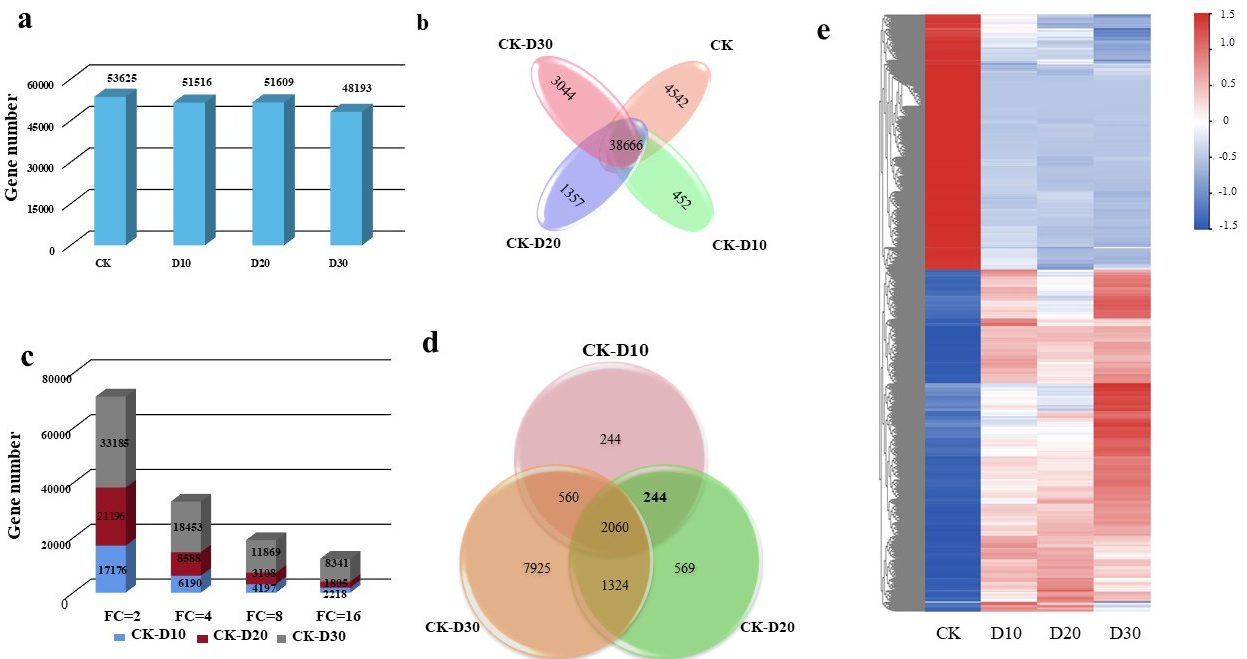
Figure 2. The DEGs’ overview. ( a ) A histogram of the numbers of valid genes in the four samples. ( b ) Venn diagram showing the identification of valid genes in the four samples. ( c ) The number of DEGs with different fold changes. ( d ) Statistical analysis of DEGs among the samples. ( e ) The heat map of DEGs in the four samples.